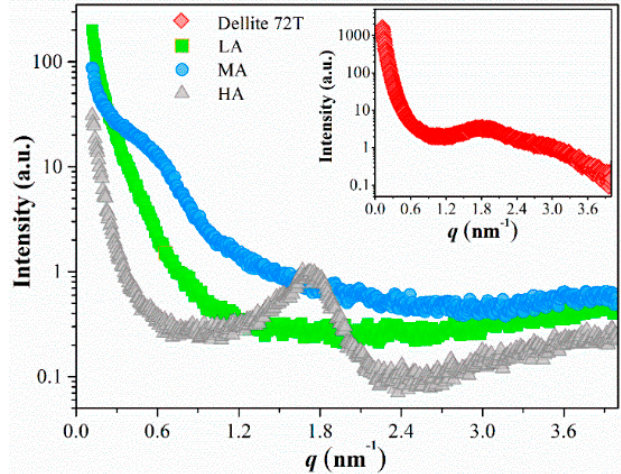
Figure 3. SAXS plots of OMMT and starch-based nanocomposites with